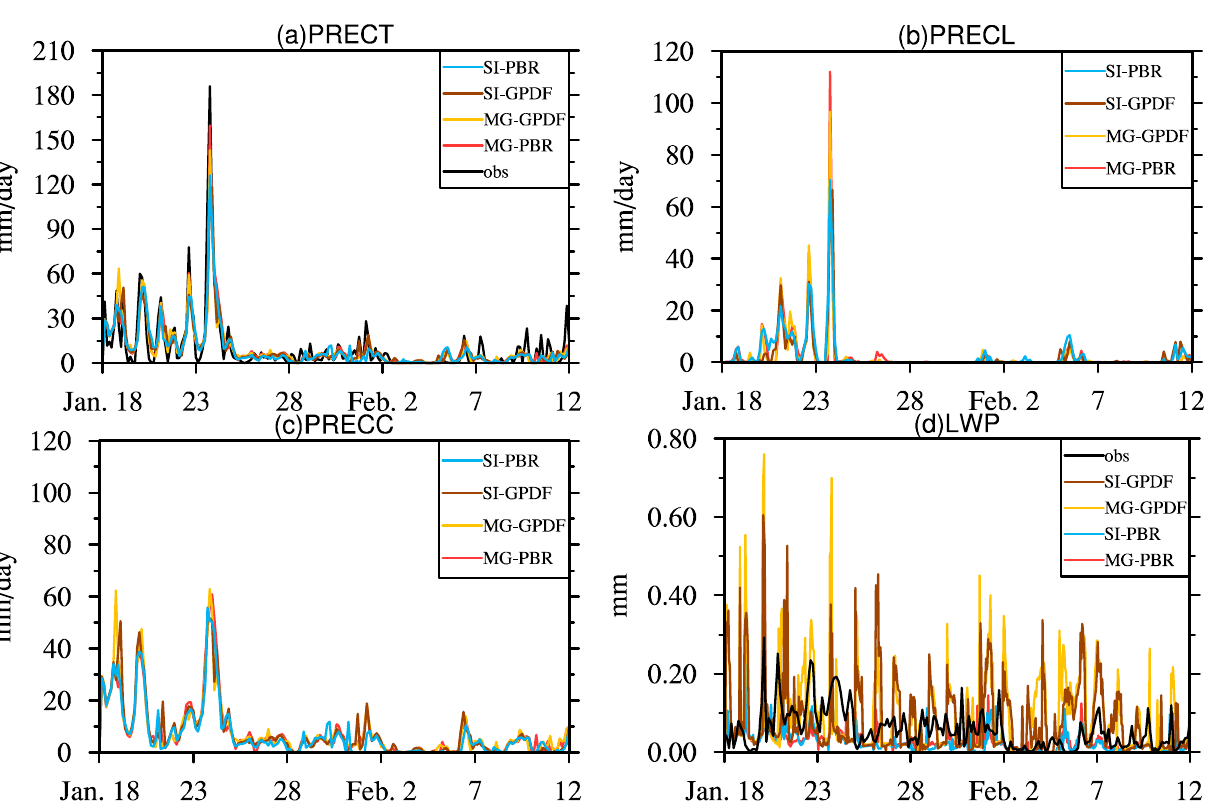
Figure 4. ( a ) Total precipitation rate, ( b ) large-scale precipitation rate, ( c ) convective precipitation rate and ( d ) liquid cloud